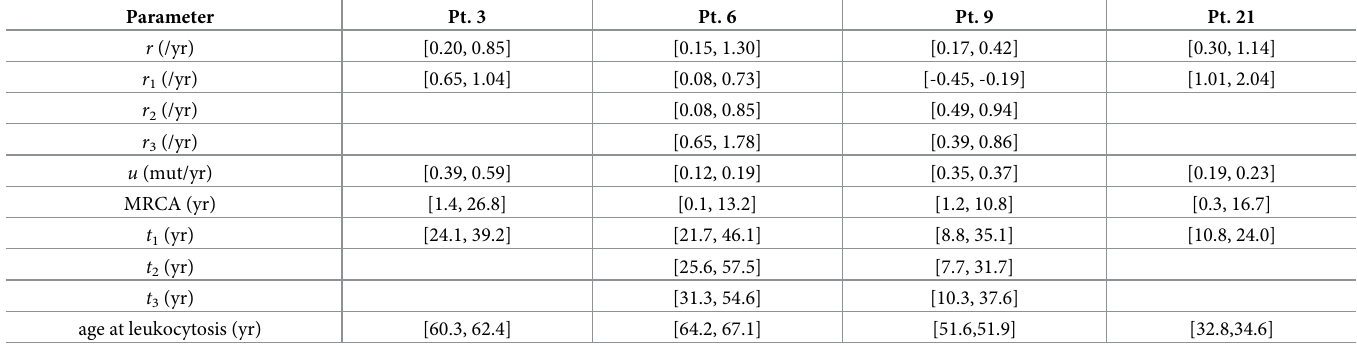
and size. For calculation of the γ mutations between frequencies f and f , we set f = 1% due 1 2 1 obs to the difficulty of detecting low frequency variants < 1% [48, 49]. We set f to 20% to minimize 2 overlap with potential driver mutations of the macroscopic subclones. The average γ for the obs four analyzed patients ranges from 2.5 to 19.3, with a median of 5.2. As in Ref. [27], we per- form subclonal reconstruction for each patient using PhylogicNDT [43]. To obtain confidence intervals for our parameter estimates, we utilize a sampling procedure to account for model and measurement uncertainties, including uncertainties in subclone frequencies, fitted growth curves, and the Poisson process for mutation accumulation (see Materials and methods). For each patient’s tumor, we compute estimates of the growth rate of each clone, exome mutation rate, the times that each subclone arose, and how long each subclone expanded before the tumor was detected (Tables 1 and 2). We also estimate what time the cancer was clinically detectable, by sampling from the distribution of fitted growth parameters and solving the resulting root-finding problem for time to reach detectable size under our growth model (see Materials and methods). For CLL specifically, we compute time of leukocytosis—an abnor- mally high WBC count. We reconstruct these histories for tumors with various clonal structures. Table 2. Confidence intervals for inferred parameters for CLL patients with exponential growth patterns, for which there are at least two longitudinal bulk sequenc- ing measurements before treatment. Estimates are computed from tumor size measurements and mutation frequencies from whole exome sequencing. Mutation rates are for the exome only. The time estimates are in terms of the patient’s age in years. Parameter Pt. 3 Pt. 6